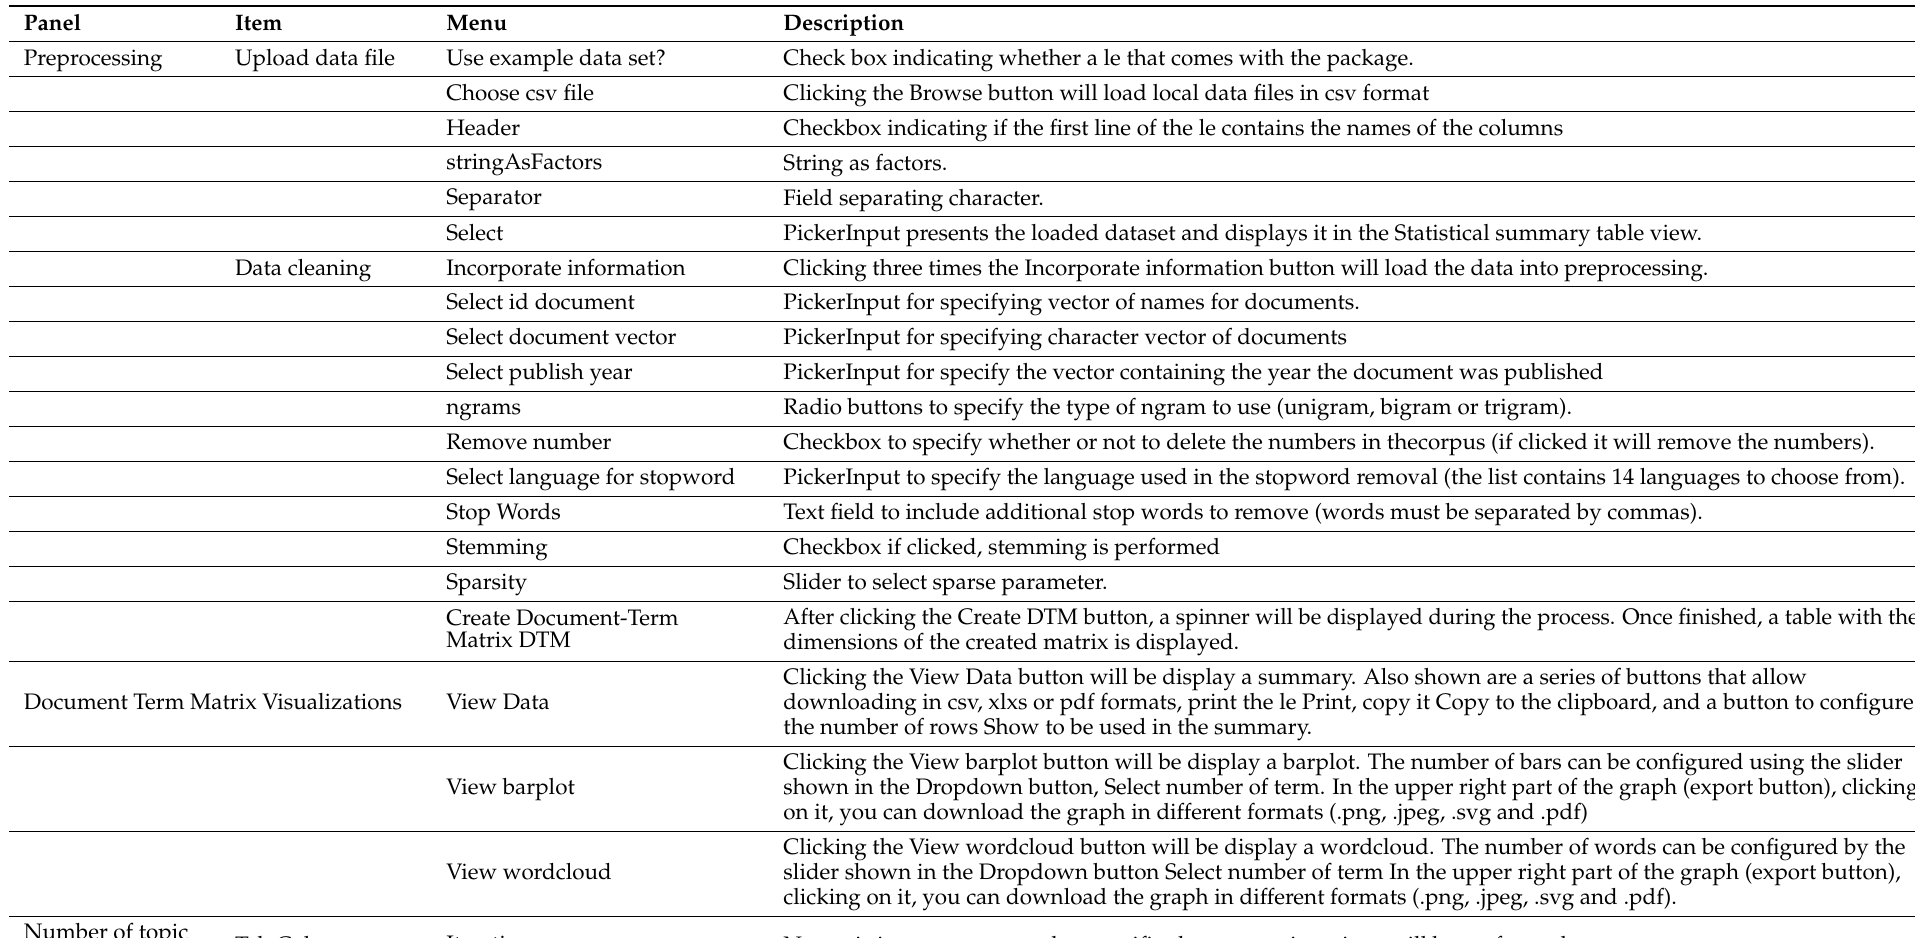
Table 1. Details and description of LDAShiny